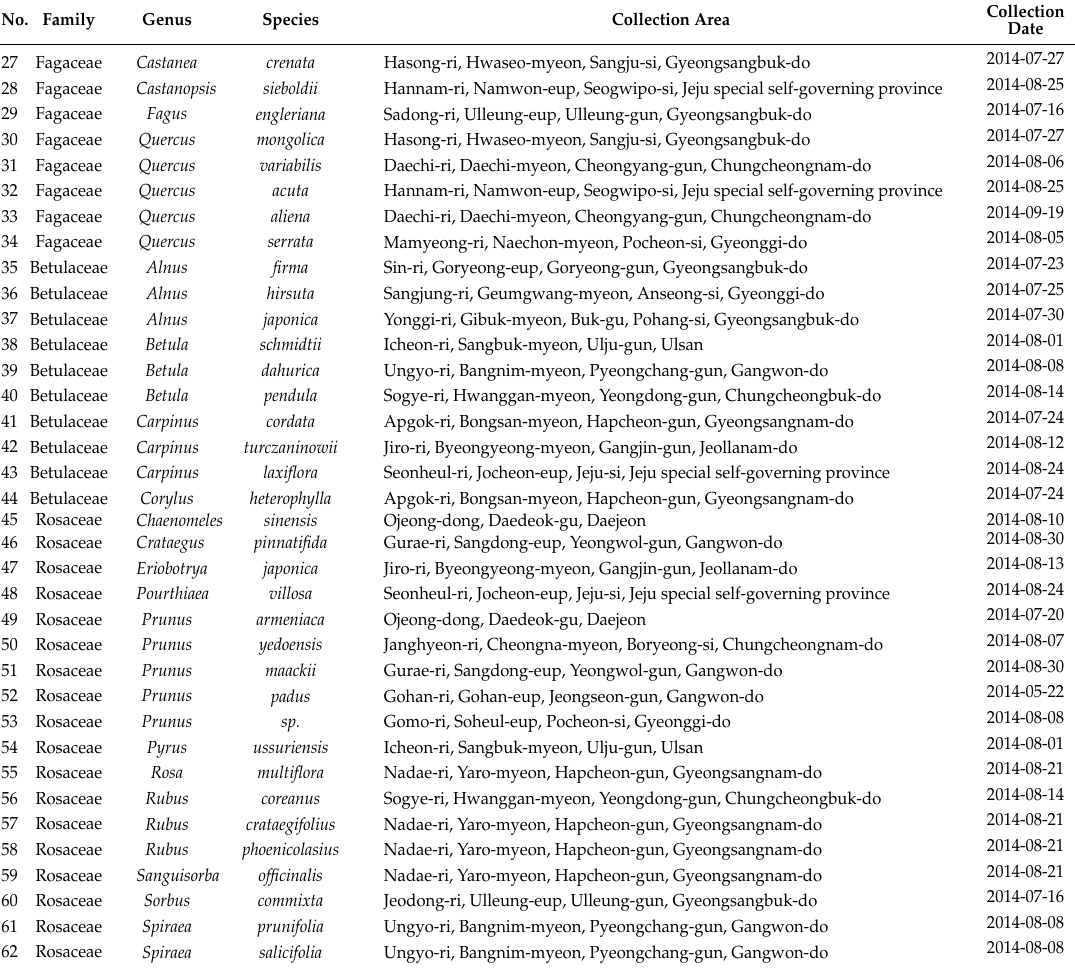
correlation coefficient between metabolites and bioactivity assays. After multivariate statistical analysis, significantly different metabolites were positively identified using standard compounds by comparing both mass spectra and retention time. When standard compounds were not available, a tentative identification was performed based on the MS spectra using the NIST05 MS Library (NIST, 2005), combined chemical dictionary version 7.2 (Chapman and Hall/CRC), and